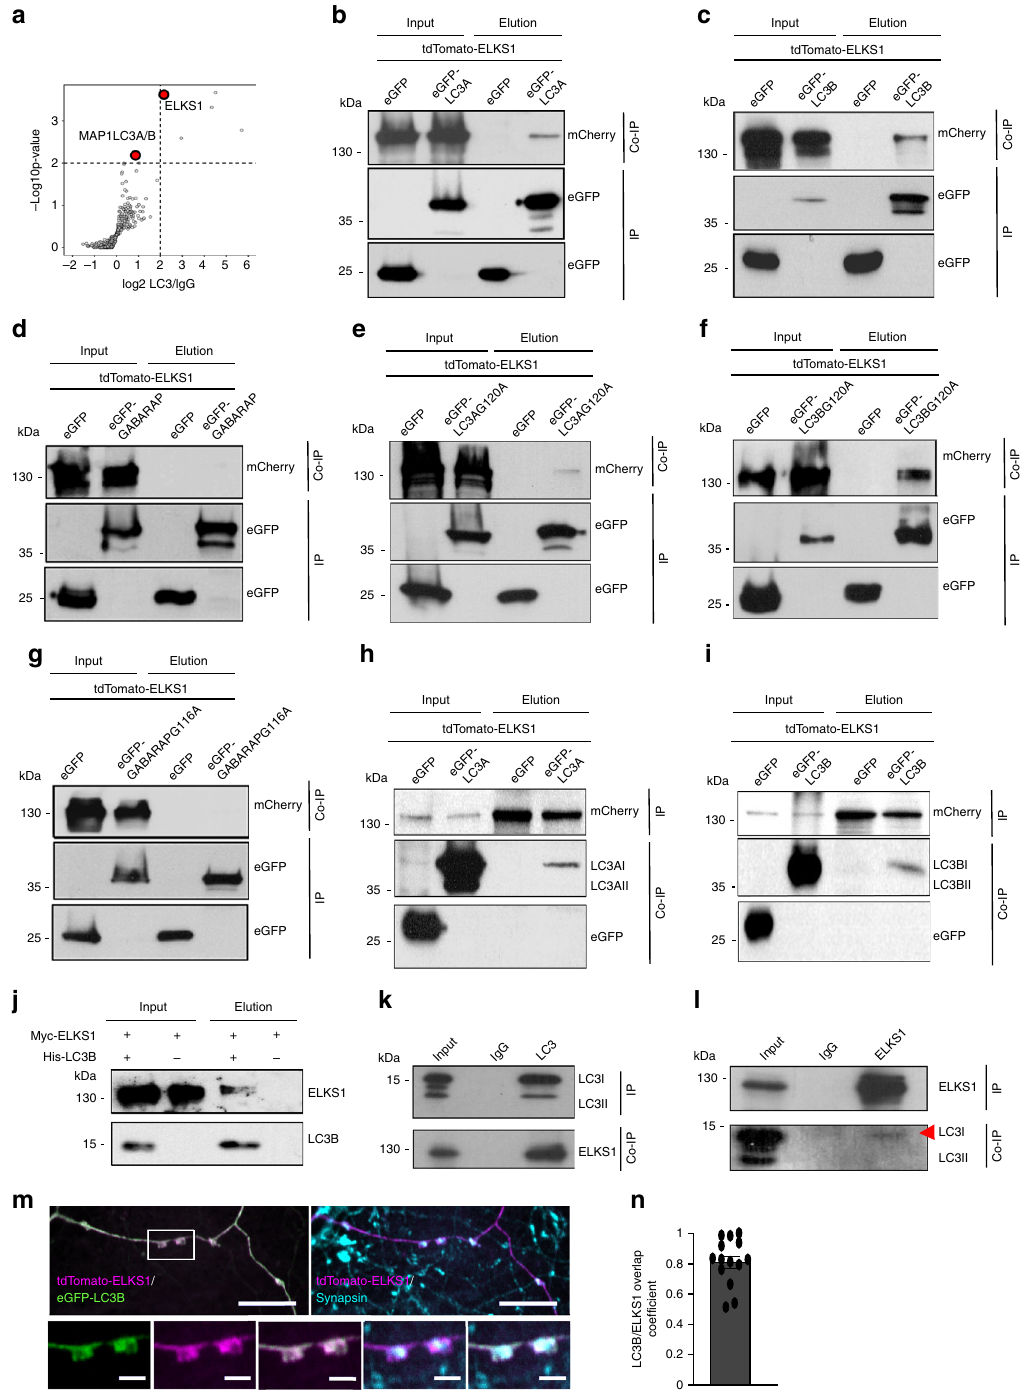
TRKB in distal neurites 47 and the retrograde transport of BDNF- activated TRKB receptors is required for the autocrine regulation of nuclear Bdnf expression 48 . Given the fact that retrograde transport of TRKB receptors is impaired in ATG5 KO neurons (see Fig. 3) one would expect the BDNF/TRKB signaling to be reduced in these cells. As predicted, we observed that levels of BDNF-activated TRKB (p-TRKBY816), as well as the activation of its main downstream targets ERK1/2 and AKT were sig- ni fi cantly decreased in ATG5-de fi cient neurons (Fig. 7a, b). In agreement with autocrine regulation of Bdnf gene expression, the levels of Bdnf mRNA, but not the mRNA levels of TrkB were